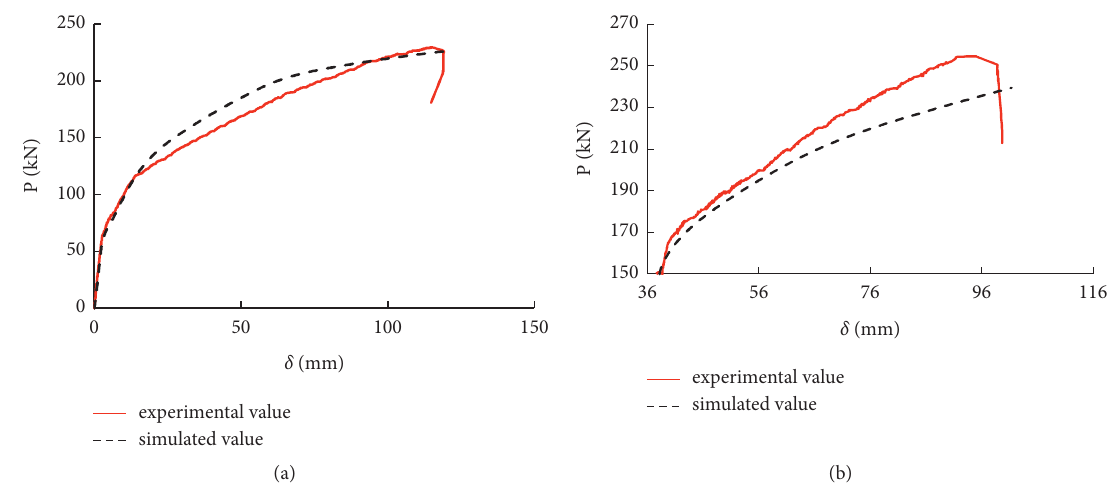
Figure 3: Comparison of the load-deformation curves between simulative and experimental results: (a) PCB0 and (b)